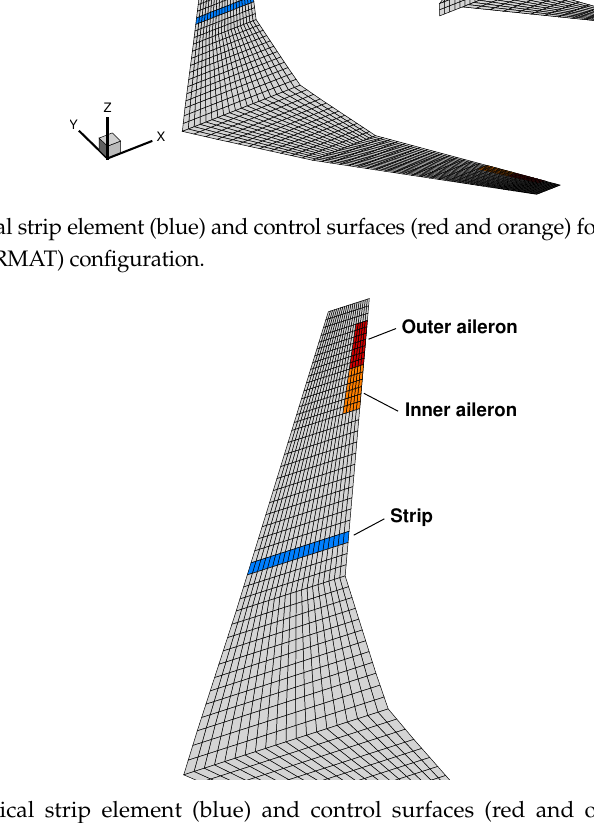
Figure 9. Typical strip element (blue) and control surfaces (red and orange) for the FERMAT configuration (view of the right wing